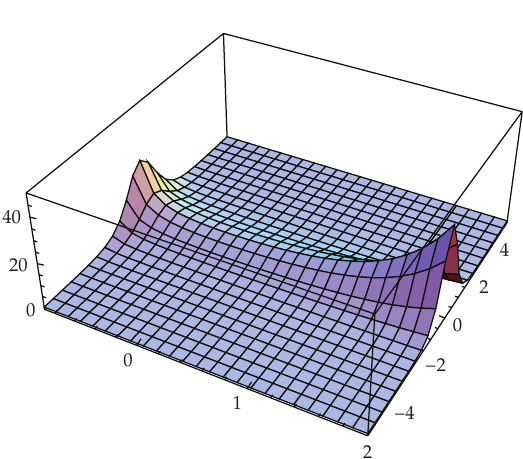
Figure 6: Three-dimensional graph of the Wronskian W α (cid:3) X (cid:4)